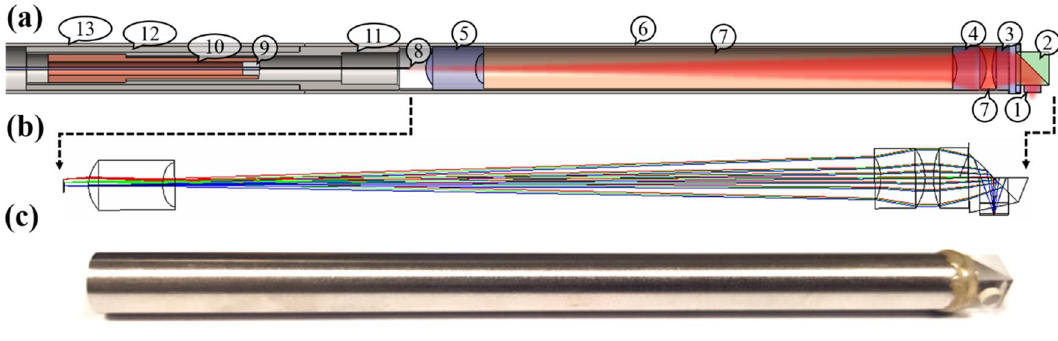
Figure 1. Overview of ultrafast laser surgery system. ( a ) Opto-mechanical design of surgery probe. The probe focuses the laser beam (red trace) onto a sub-surface tissue plane using a miniaturized objective consisting of a sapphire window (1), reflective microprism (2), ZnS lens (3), and two CaF 2 lenses (4 and 5). All optical components are housed within a 304SS hypodermic tube (6) and distances between the three lenses are set by brass spacers (7). The locus of the scanned Kagome fiber tip (8) is mapped in Zemax to simulate the path of the rays from the focal plane back through the objective. A PMMA insert (9) centered the fiber within the inner cavity of a piezo-electric tube (10). The piezo electric tube (10) was centered within an 304SS inner casing (11) using an accurately turned epoxy plug. The inner casing (11) was centered within the hypodermic tube (6) to align the piezo-HCPCF assembly to the miniaturized objective. Two outer casings (12, 13) were added to secure the backend of the probe to the miniaturized objective. ( b ) Optical schematic of miniaturized objective. A ray trace depicts different launch angles from the fiber tip through the system. ( c ) Final assembly and packaging of miniaturized objective in hypodermic